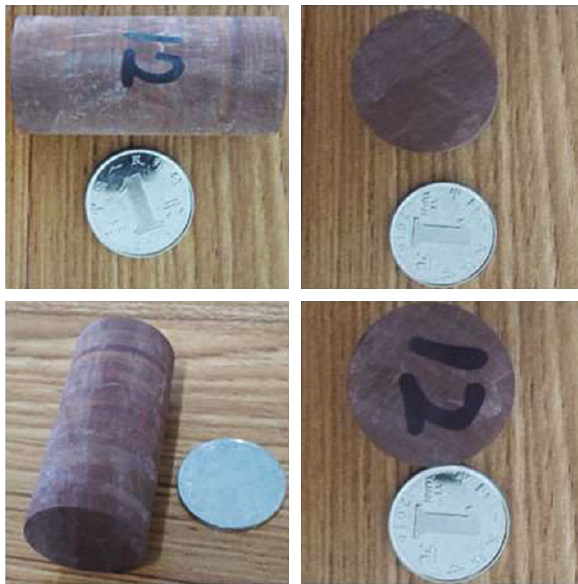
Figure 5: Tight sandstone core of the rock